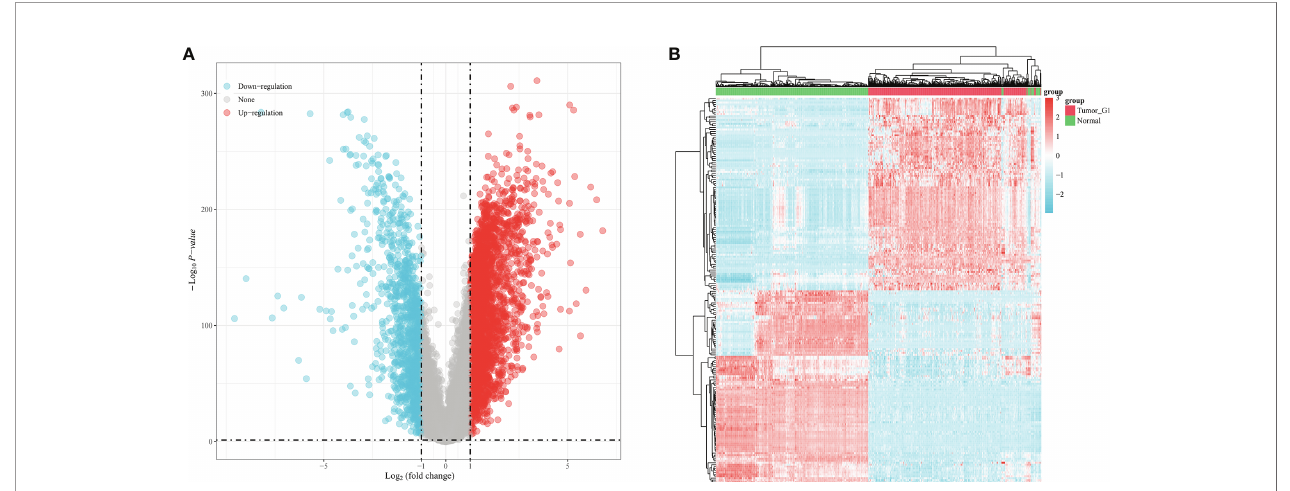
FIGURE 1 | Expression levels of m6A RNA methylation regulators in TCGA database. (A) Expression levels of 20 m6A RNA methylation regulators in 375 STAD tissues and 32 normal tissues of the TCGA database. (B) Pearson's test for the correlation between the expression levels of 20 m6A RNA methylation